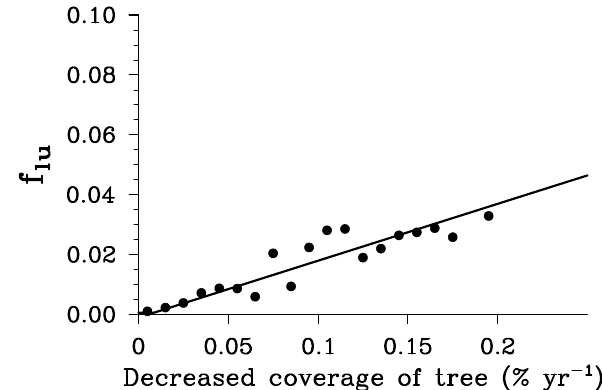
Fig. 4. Effects of decreases of tree coverage on annual burned area, f lu (line). 0.5 ◦ GFED3 burned area fraction in Amazon rainfor- est (tropical closed forest in 15.25 ◦ S–10.25 ◦ N, 30.75–90.75 ◦ W) is partitioned over 0.01% yr − 1 deforestation rate bins. Black cir- cles indicate the average burned area fraction in bins with sample size > 5. Goodness of fit is 0.83 ( n =